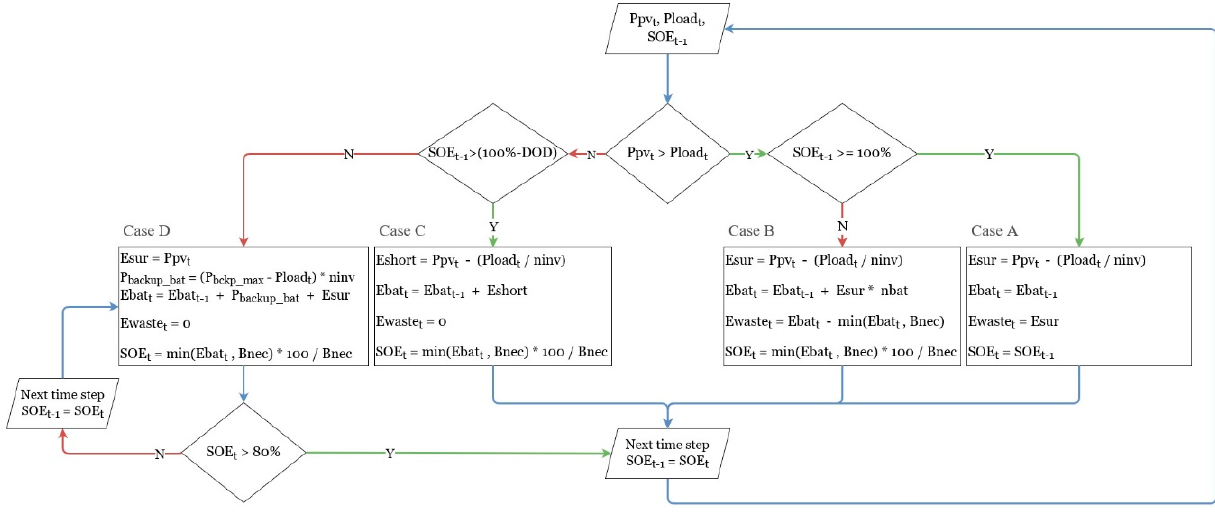
Figure 5. System operation flow according to the to the hourly battery state of energy and PV energy usage.